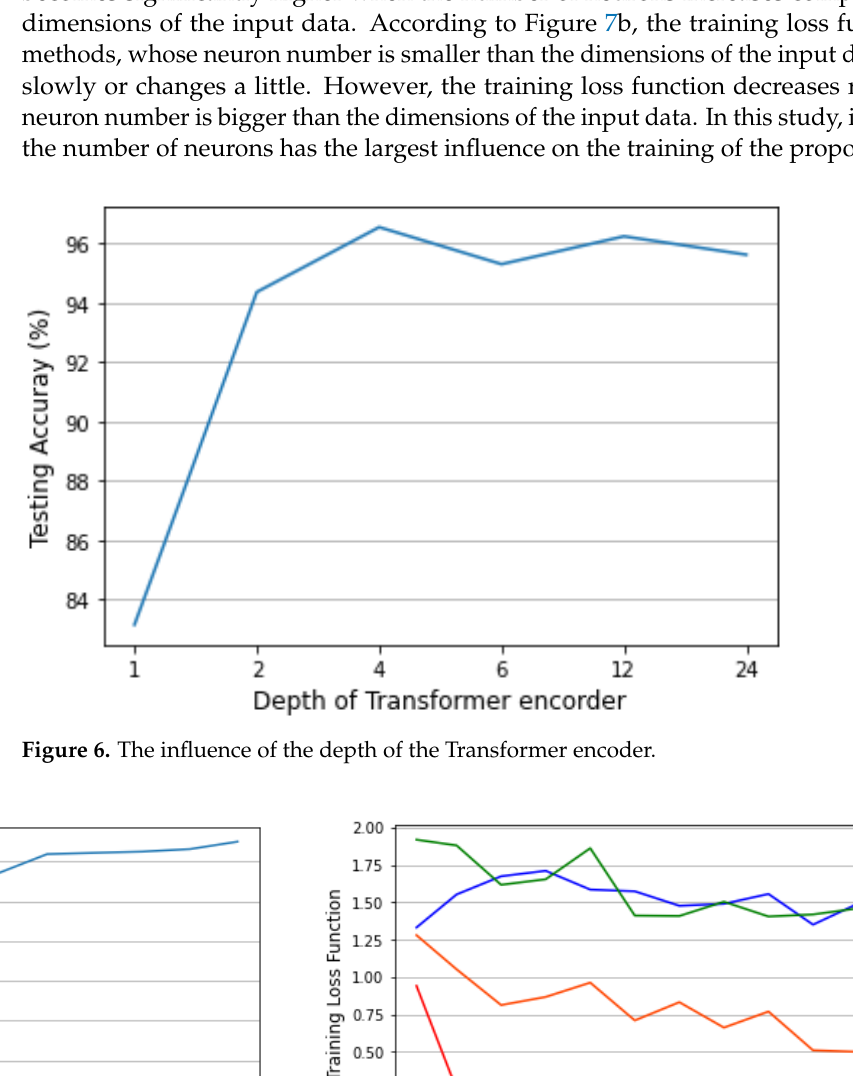
Figure 6. The influence of the depth of the Transformer encoder.